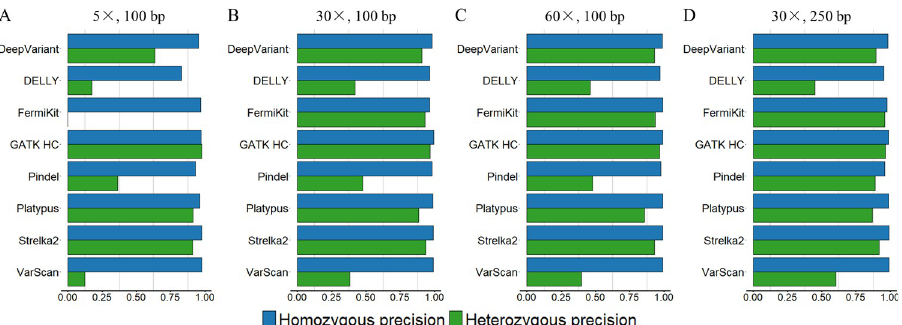
Fig 5. Homozygous and heterozygous precisions of variant calling tools using the semi-simulated dataset. (A) 5 × coverage, 100bp read length sequencing data. (B) 30 × coverage, 100bp read length sequencing data. (C) 60 ×